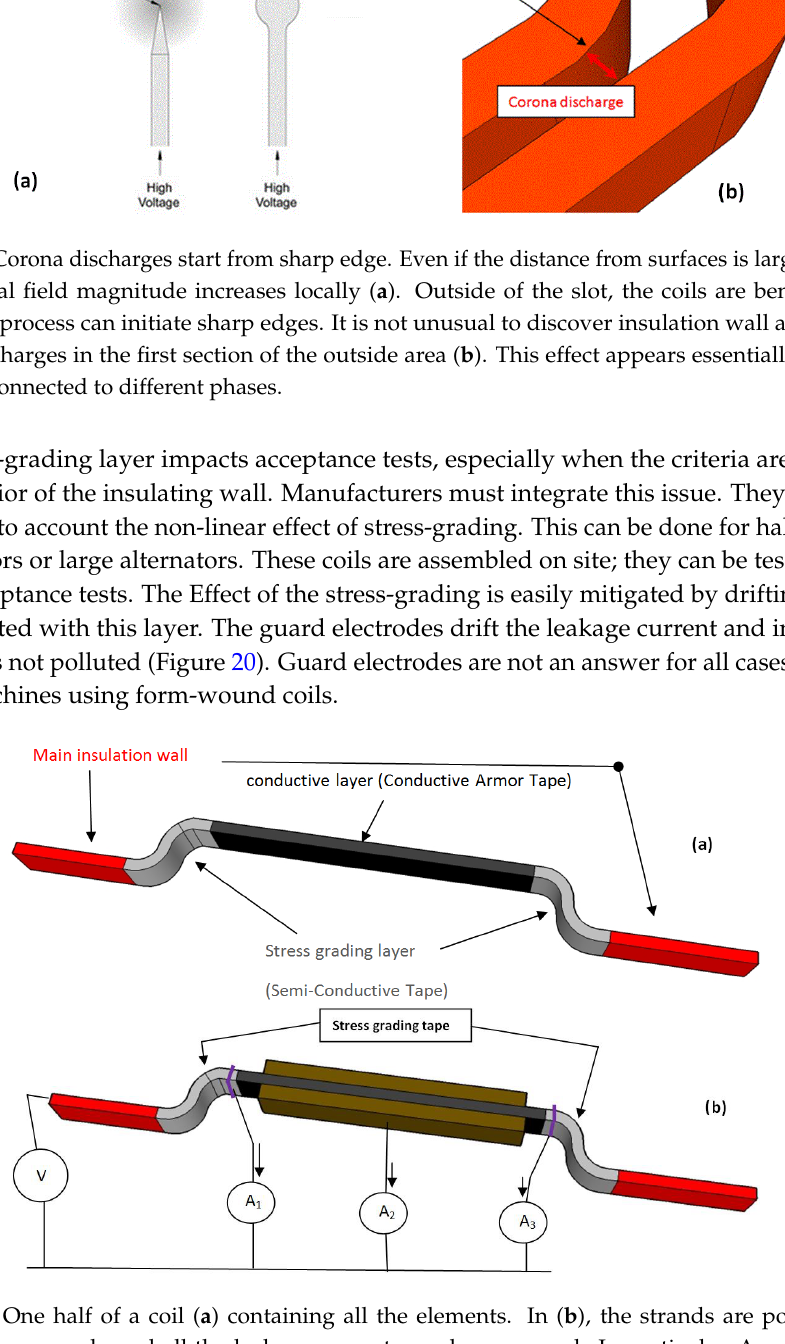
Figure 19. Corona discharges start from sharp edge. Even if the distance from surfaces is large enough, the electrical field magnitude increases locally ( a ). Outside of the slot, the coils are bent and the handmade process can initiate sharp edges. It is not unusual to discover insulation wall affected by corona discharges in the first section of the outside area ( b ).This effect appears essentially for coils which are connected to different phases.